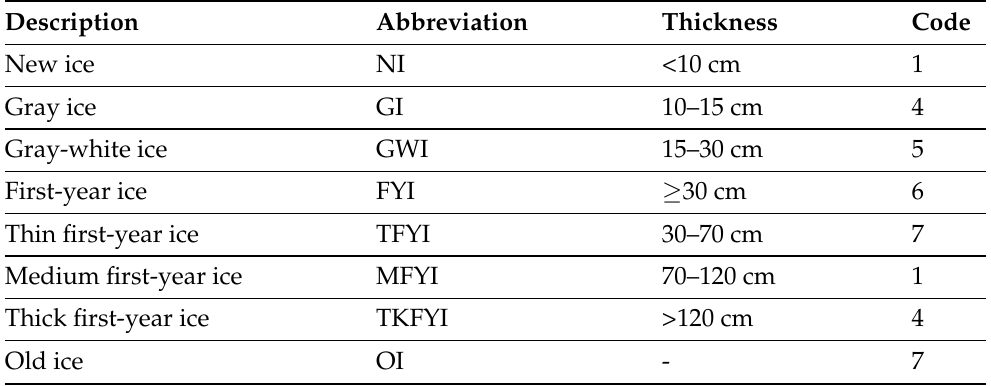
Table 1. Sea ice types and the corresponding stage of development (age) egg codes